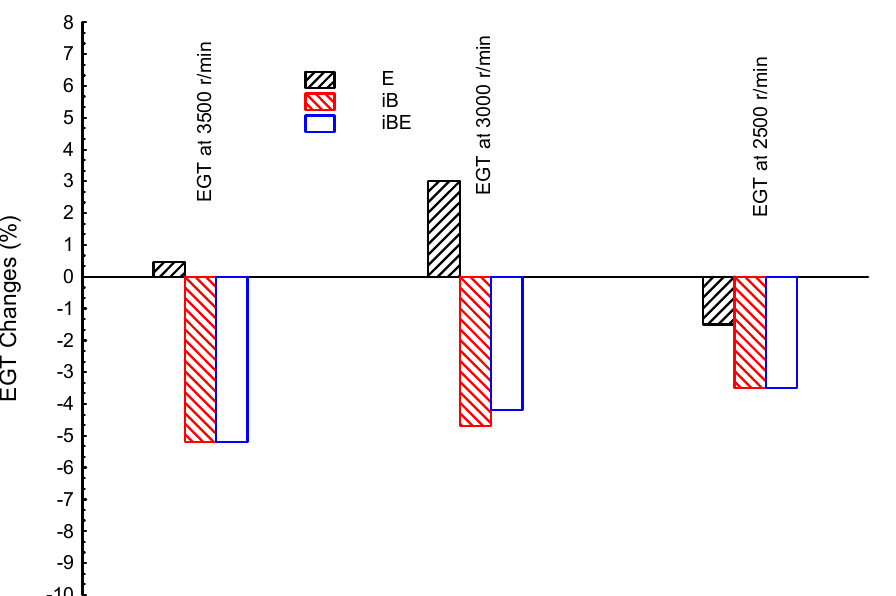
Figure 4. Exhaust gas temperature (EGT) at three different engine speeds (3500, 3000, and 2500 r/min) for blended fuels of iso-butanol–bio-ethanol–gasoline (iBE), bio-ethanol–gasoline (E), and iso-butanol– gasoline (iB); gasoline is the reference line.